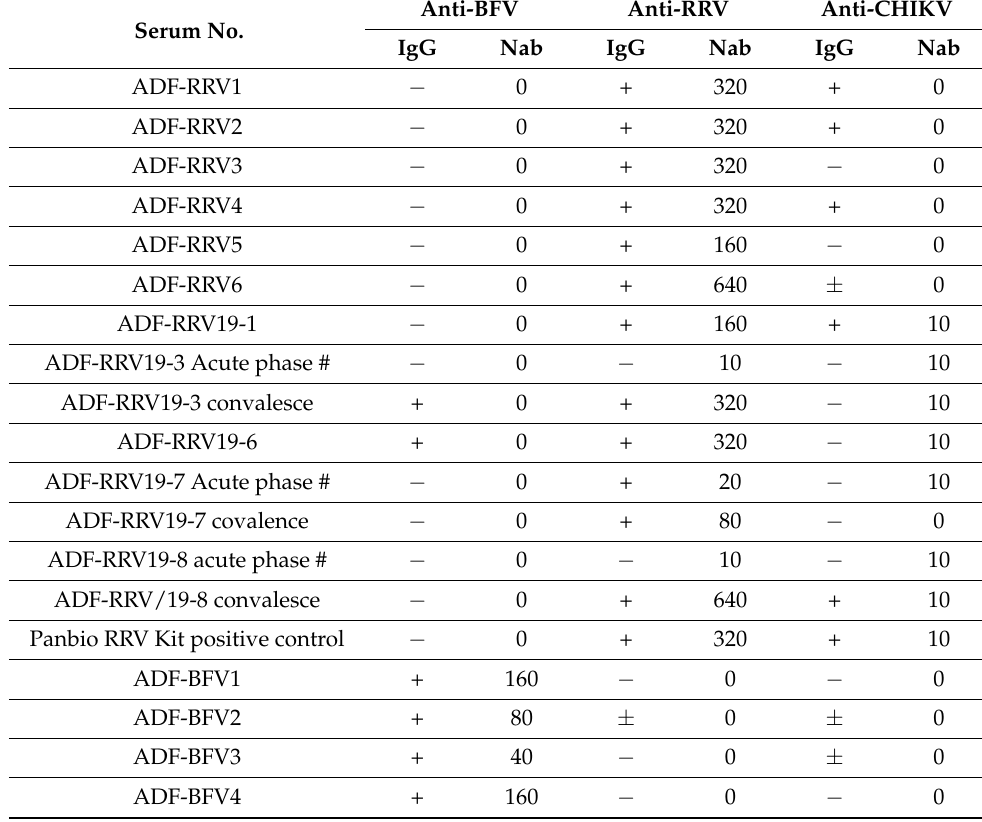
Table 3. Anti-Barmah Forest virus, anti-Chikungunya virus and anti-Ross River virus antibody observations for our RRV-, BFV- and CHIKV-infected personnel, as well as negative controls. Serum